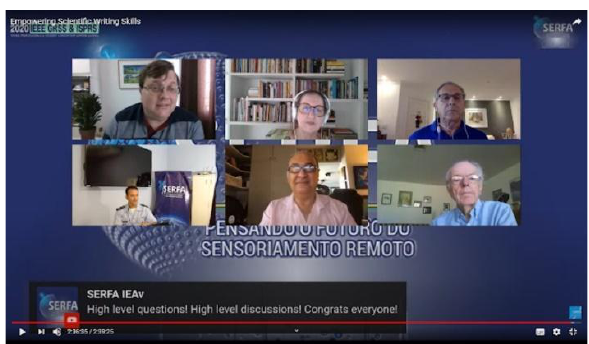
Figure 6 . The special session in SERFA 2020 on "Empowering Scientific Writing